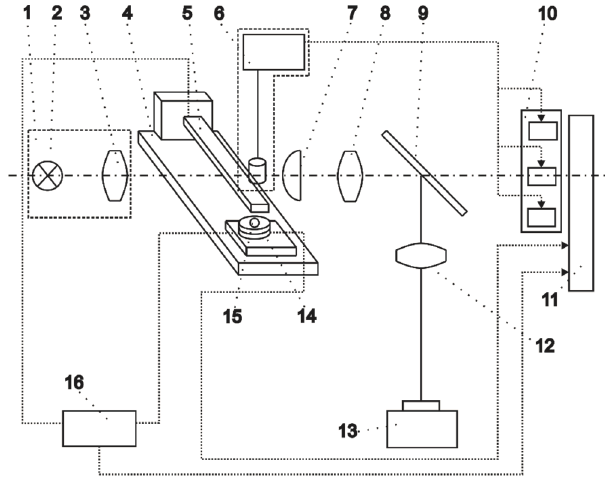
Figure 8. Vibro-impact experimental